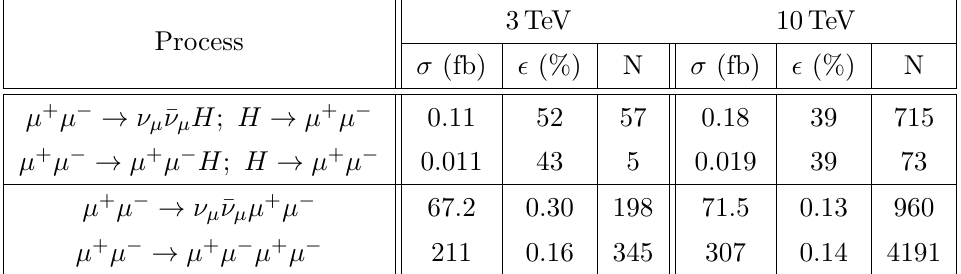
Table 7 . Signal and most important backgrounds for the H → µ + µ − channel, after applying the cuts listed in the